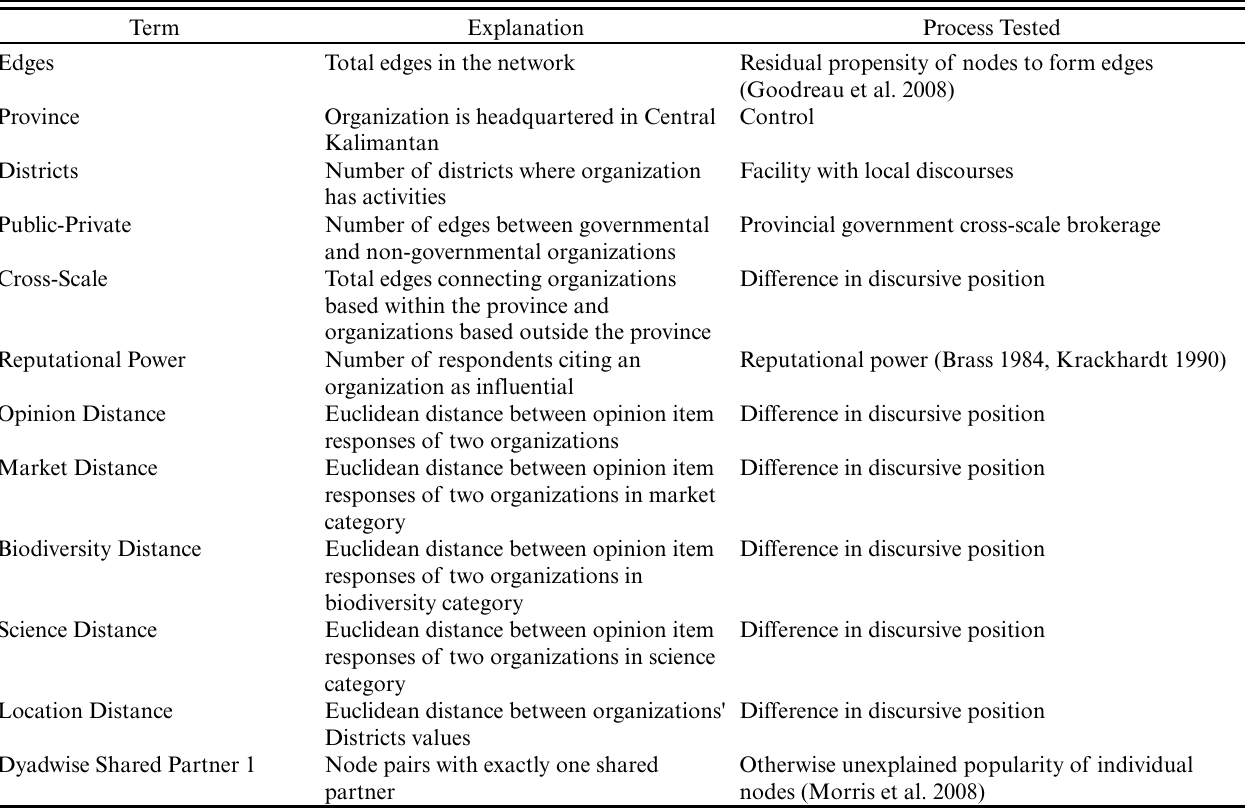
Table 1 . Explanation of exponential random graph model